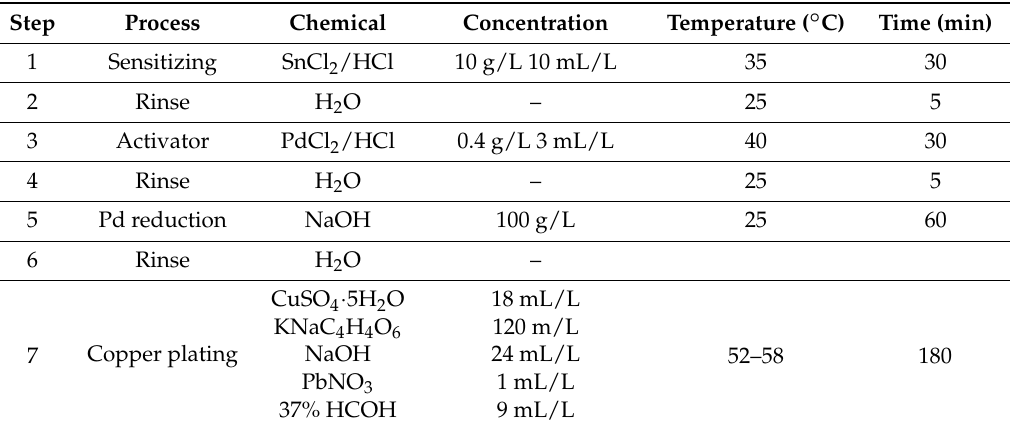
Table 1. Electroless plating process of copper on carbon fibers.